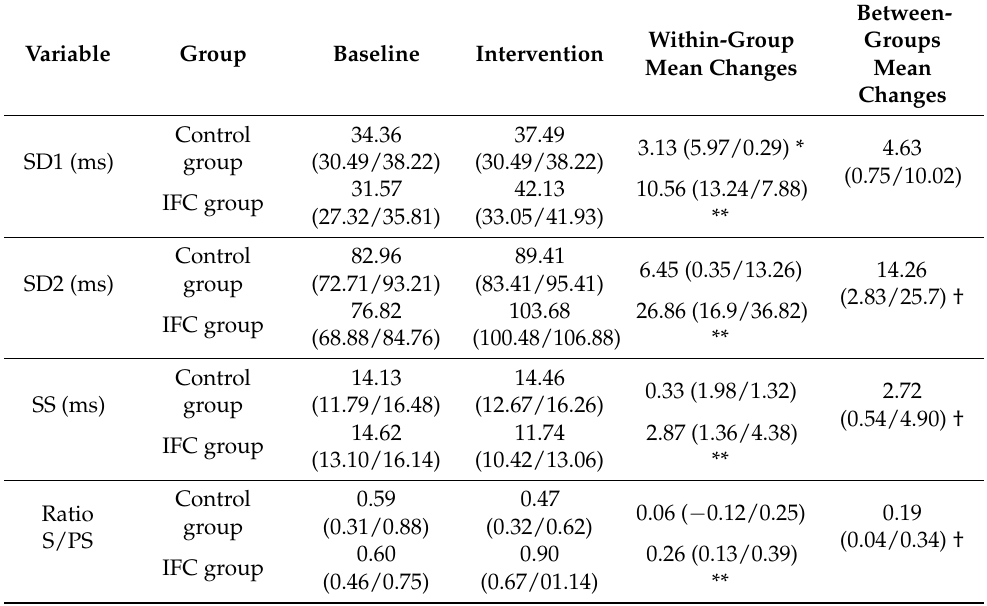
Table 2. Baseline, post-intervention, and mean score changes in heart rate variability parameters. Variable Group Baseline Intervention